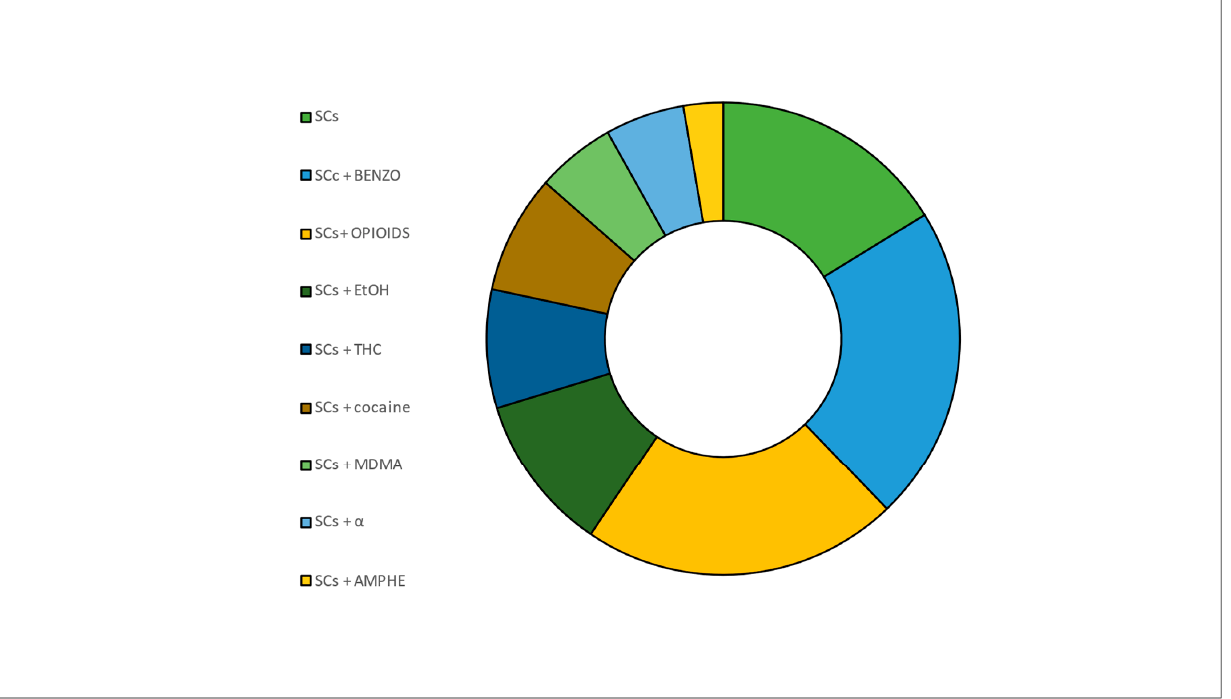
Figure 6. Di ff erent blood concentrations of SCs in intoxication cases.